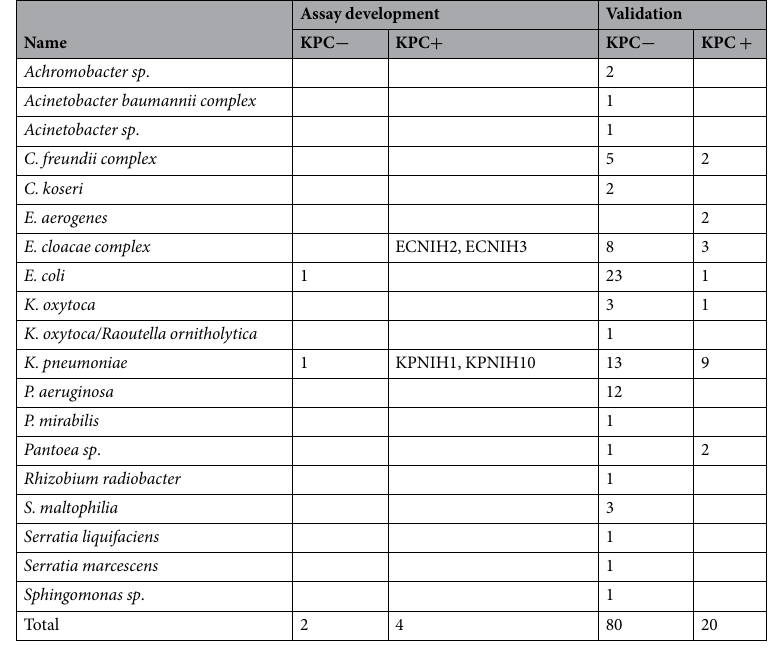
Table 1. KPC + and KPC − isolates used in assay development and